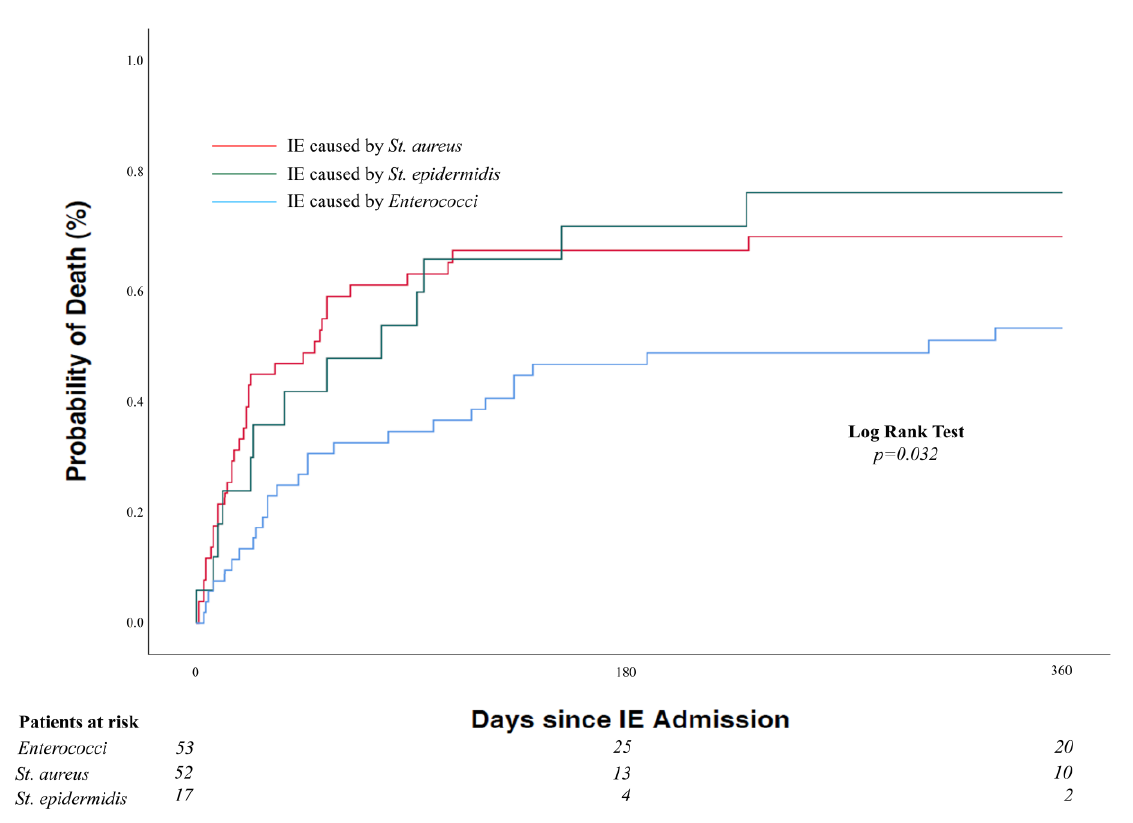
Figure 2. All-cause mortality according to IE caused by enterococci versus St. aureus versus coagulase- negative St. epidermidis .